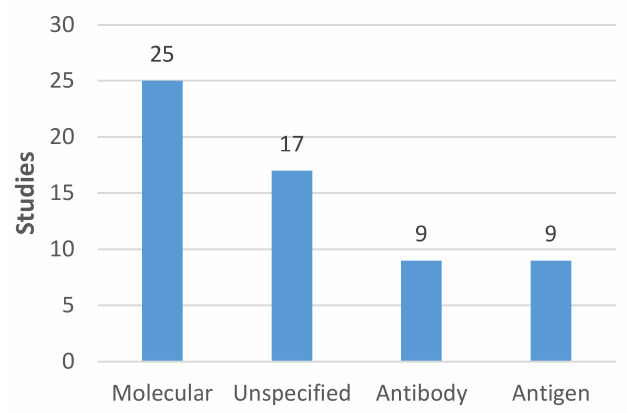
Figure 4. Test type.